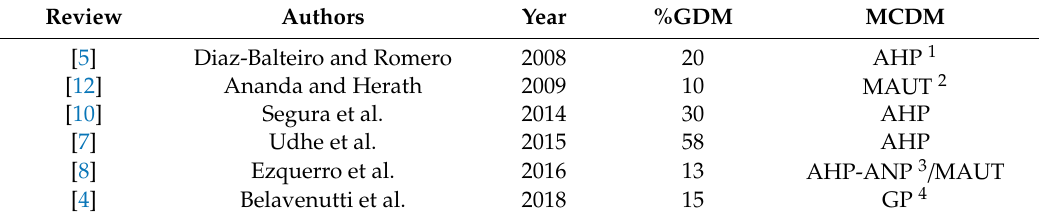
Table 1. Percentages of GDM and multicriteria techniques most used in di ff erent reviews analysed.